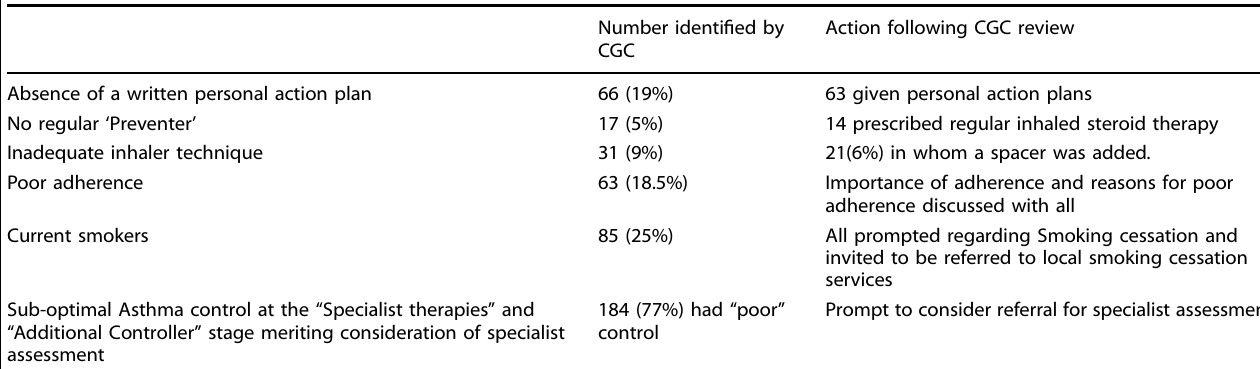
Table 4. Management changes prompted by